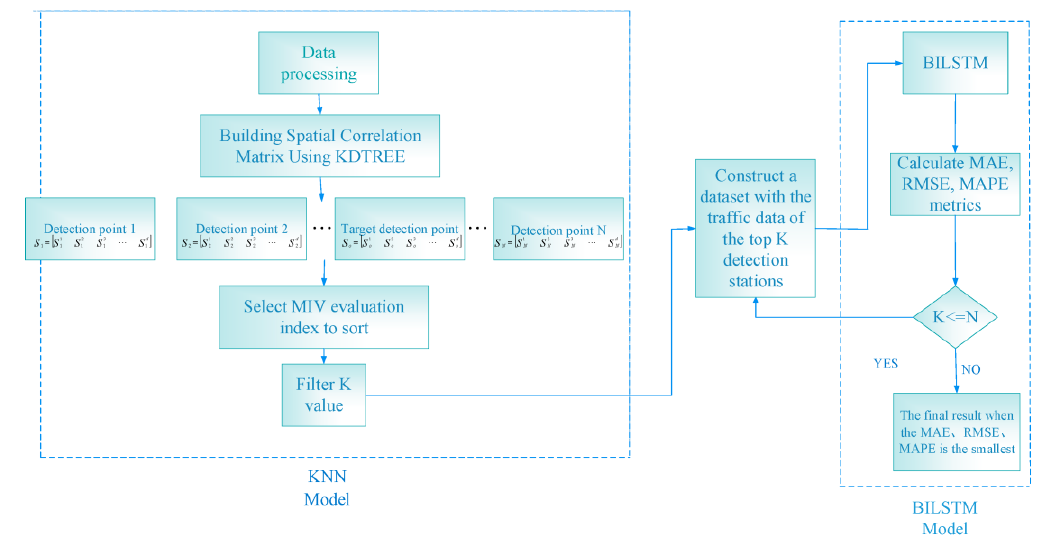
Figure 2. Traffic flow prediction flow chart.